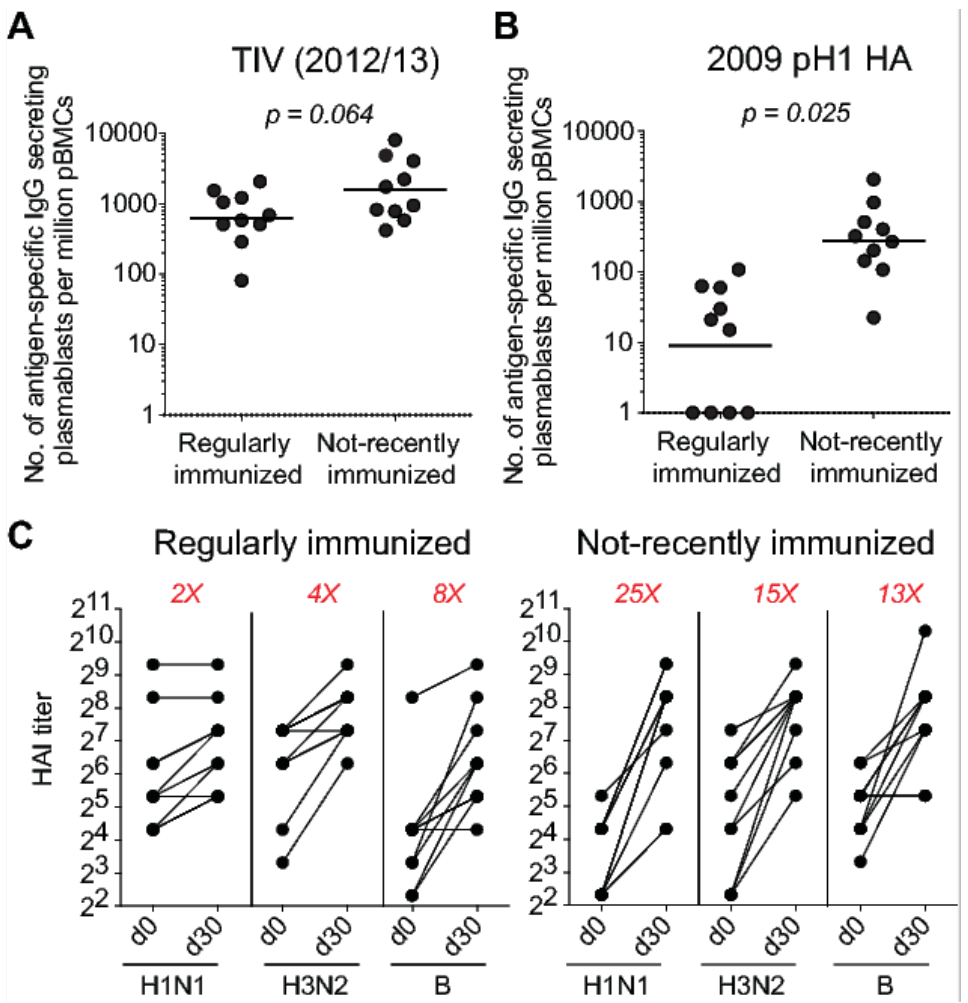
Figure 2. Pre-existing immunity blunts B cell response to seasonal influenza vaccination. Healthy adult volunteers were vaccinated with the 2012/13 inactivated seasonal influenza vaccine ( n = 20). ( A ) Frequency of IgG-secreting plasmablasts directed against the vaccine antigen in regularly immunized ( n = 10) and not-recently immunized ( n = 10) subjects. ( B ) Frequency of IgG-secreting plasmablasts directed against the 2009 pandemic H1 HA (the H1N1 component of the vaccine). ( C ) Serum hemagglutination inhibition titers against the three viral strains contained in the vaccine, A/California/07/2009 (H1N1), A/Victoria/361/2011 (H3N2), and B/Brisbane/60/2008. Titers were measured before and 4 weeks after vaccination. Unpaired Student t tests were used to derive p values.